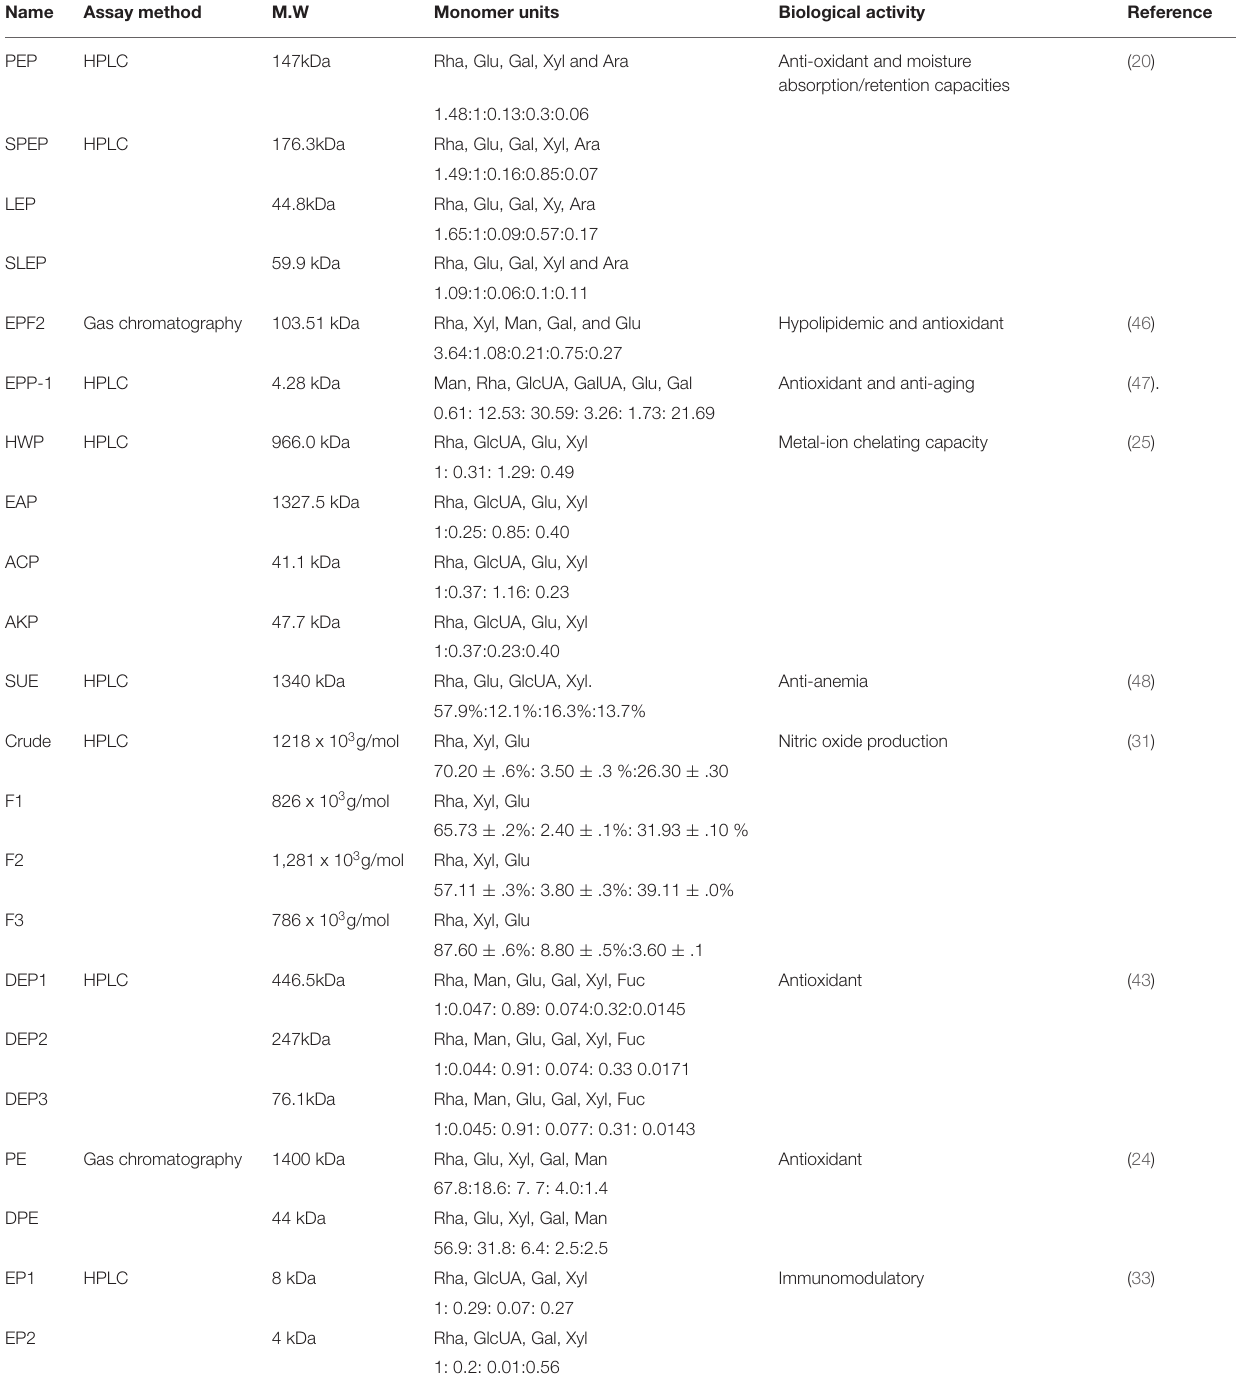
TABLE 2 | The structure and monosaccharide composition of different polysaccharides isolated from Enteromorpha prolifera . Name Assay